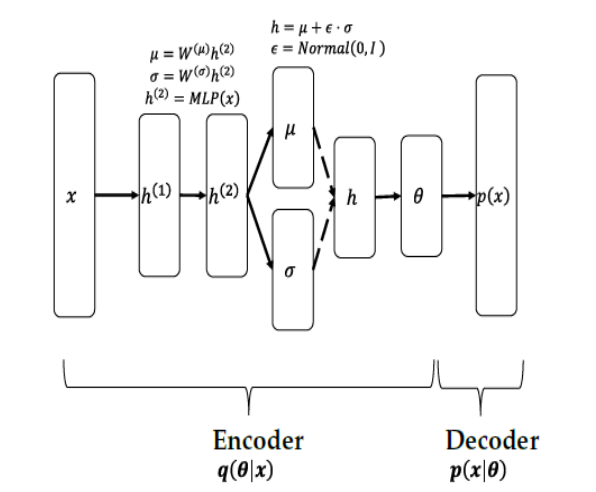
Figure 2. Representation of the model based on VAE.